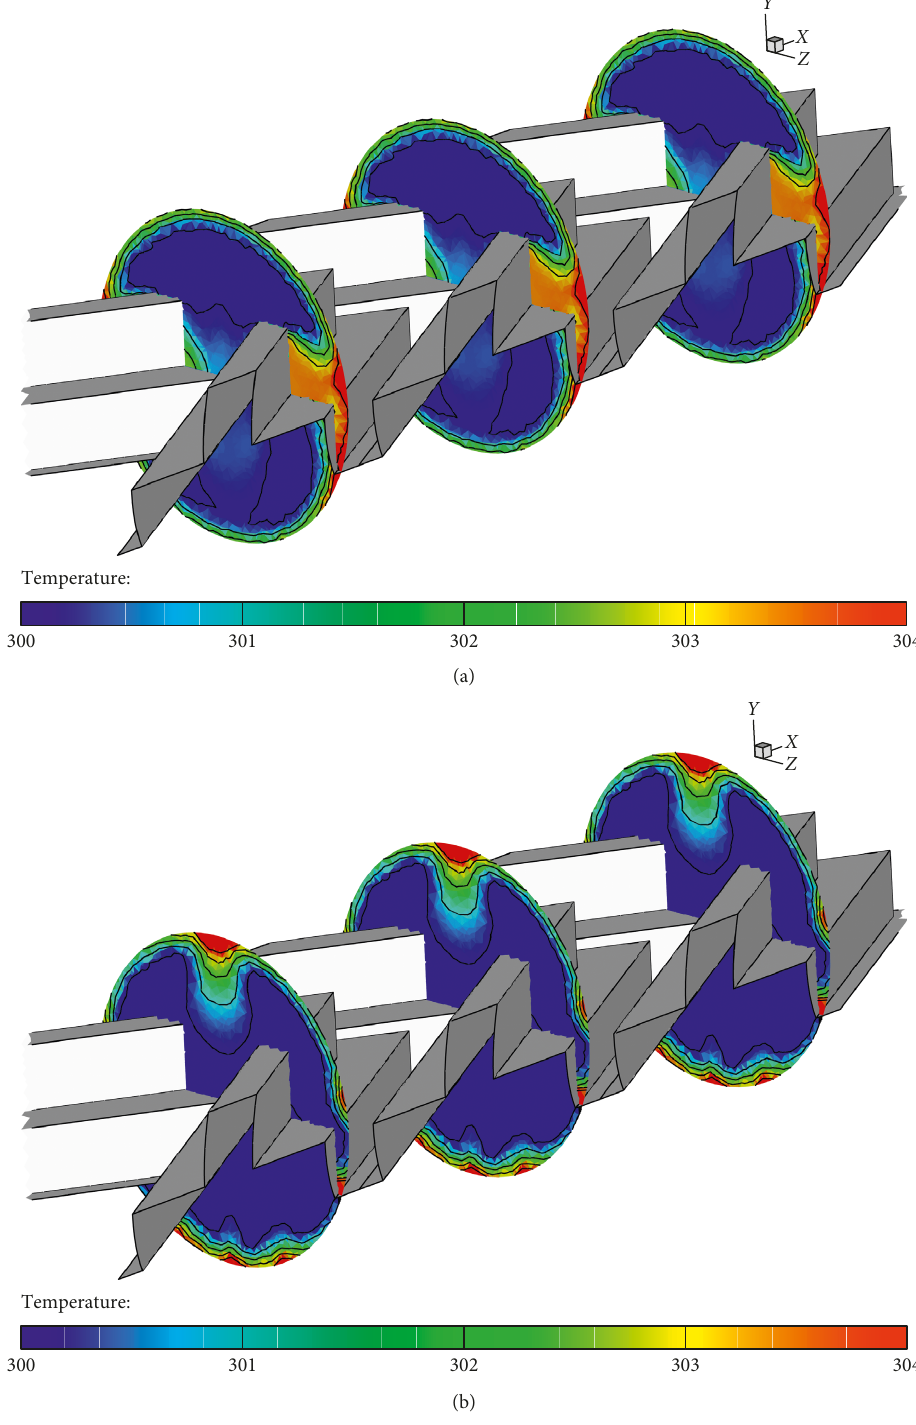
Figure 19: Temperature contour in transverse planes of the heat exchanger tube inserted with the V-wavy surface at α for (a) V-Downstream and (b)